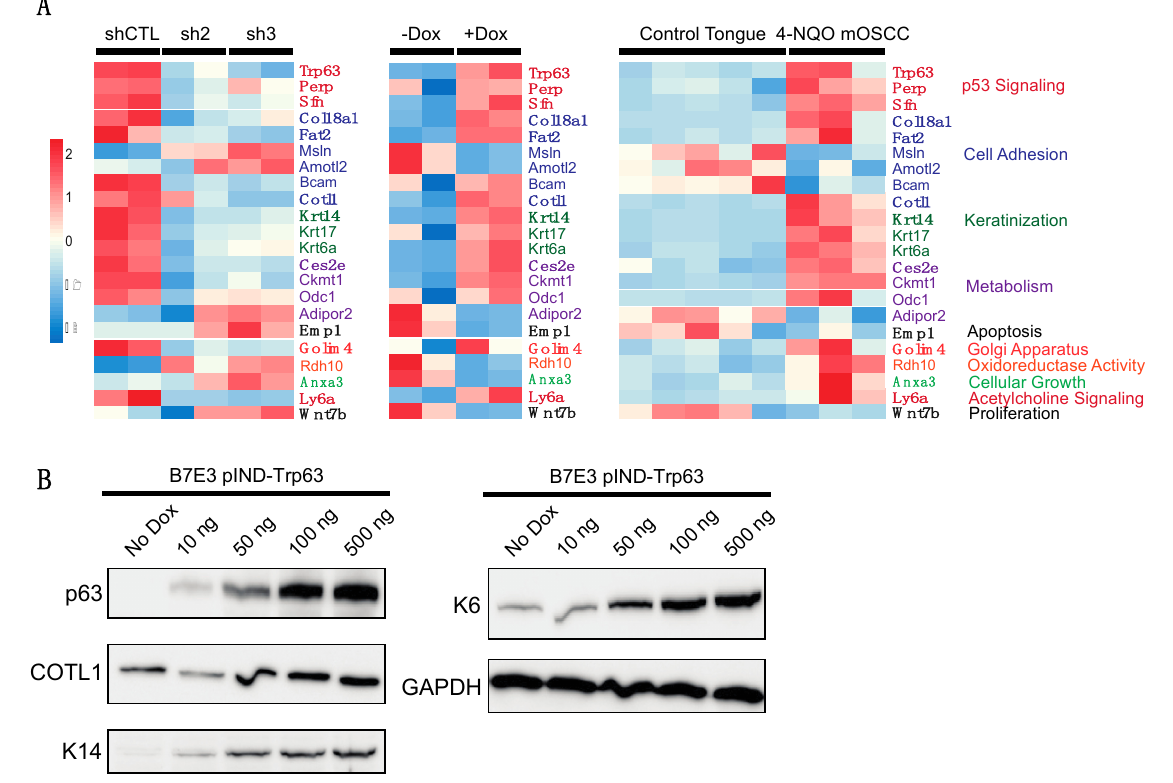
Figure 6. Combined mOSCC p63-based signature. ( A ) Heat map of the combined 22-gene signature in the B7E11 cells with p63 knockdown, B7E3 cells with induced p63 expression, and the Tang et al. [11] 4NQO mOSCC dataset. Genes in boldface are direct targets of p63, according to our high-confidence p63 target list. ( B ) Western blot analysis of the levels of proteins encoded by DEGs identified in our combined p63-based signature in B7E3 p63 overexpressing cells. GAPDH was used as a loading control.